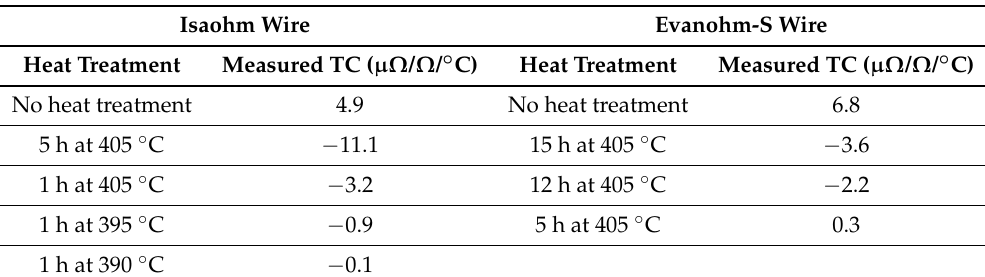
Table 4. Steps to achieve the correct heat treatment.